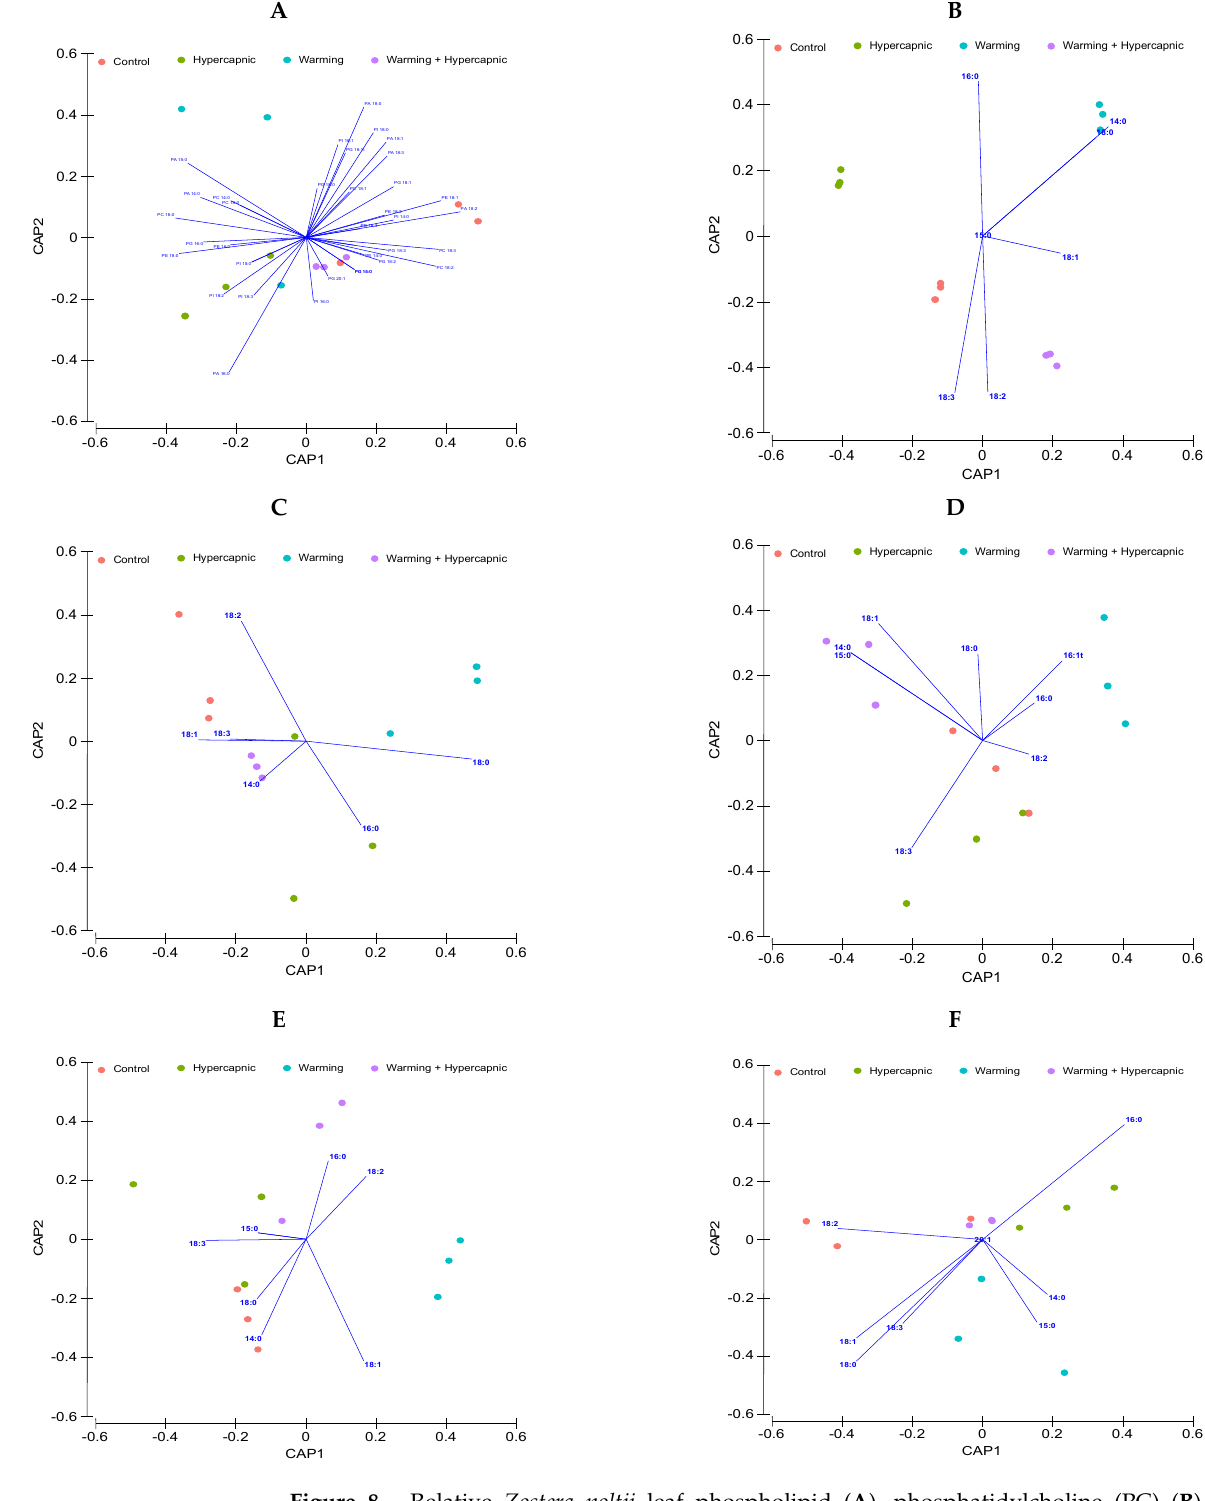
Figure 8. Relative Zostera noltii leaf phospholipid ( A ), phosphatidylcholine (PC) ( B ), phosphatidylethanolamine (PE) ( C ), phosphatidylglycerol (PG) ( D ), phosphatidylinositol (PI) ( E ), and phosphatidic acid (PA) ( F ) fatty acid concentration canonical analysis of principal (CAP) components of the samples exposed to control, hypercapnic, warming and combined stress conditions ( n = 3 per treatment).